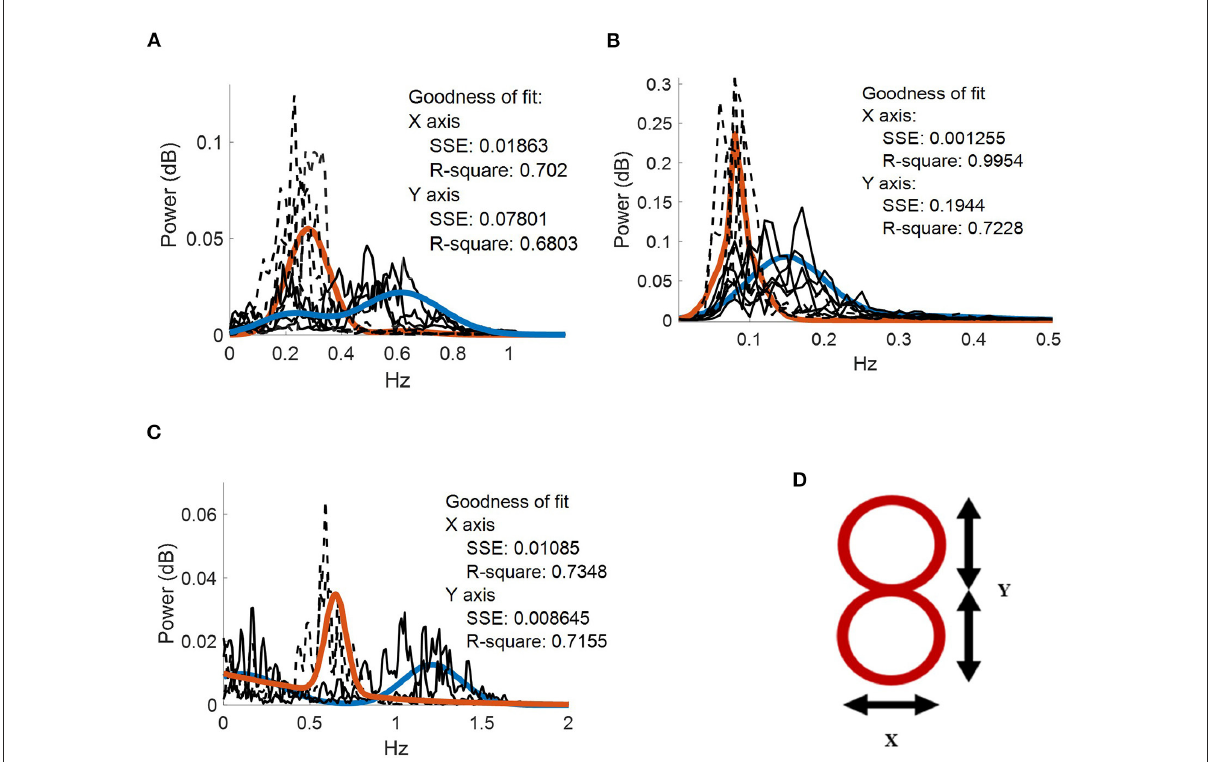
FIGURE2 Frequency spectrum of the movement kinematics at the fingertip. Two gaussian fits (blue and orange continuous traces, respectively) applied to f x (dotted black lines) and f y (dotted gray lines) task components for. (A) five repetitions performed by the patient with hemidystonia. (B) five repetitions executed by the patient with generalized dystonia; and (C) two repetitions performed by the patient with TS. Vertical axis: power spectra (dB). Horizontal axis: frequency (Hz). (D) Representation of the figure-eight drawing trace (0.3-cm thickness).